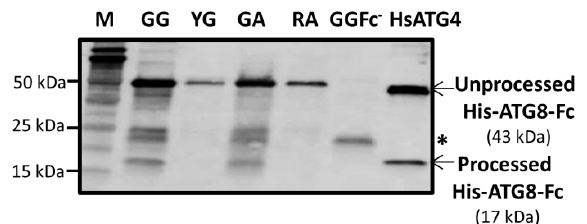
Figure 3. ATG4 cleavage activity assay in extracts of green Galena (GG), yellow Galena (YG), green Alonso (GA), and red Alonso (RA) pepper fruits. Recombinant 6His-ATG8-Fc substrate and 100 µM DTT were added to fruit extracts and incubated for 20 min before being subjected to SDS-PAGE and Western blot using anti-6His monoclonal antibody. The unprocessed 43 kDa substrate and processed ~17 kDa product are indicated. A negative control is included using GG fruits without 6His-ATG8-Fc (GGFc-) in the assay, as well as a positive control using human recombinant HsATG4B protein instead of fruit extract. The unspecific band at 30 kDa is also pointed (asterisk).